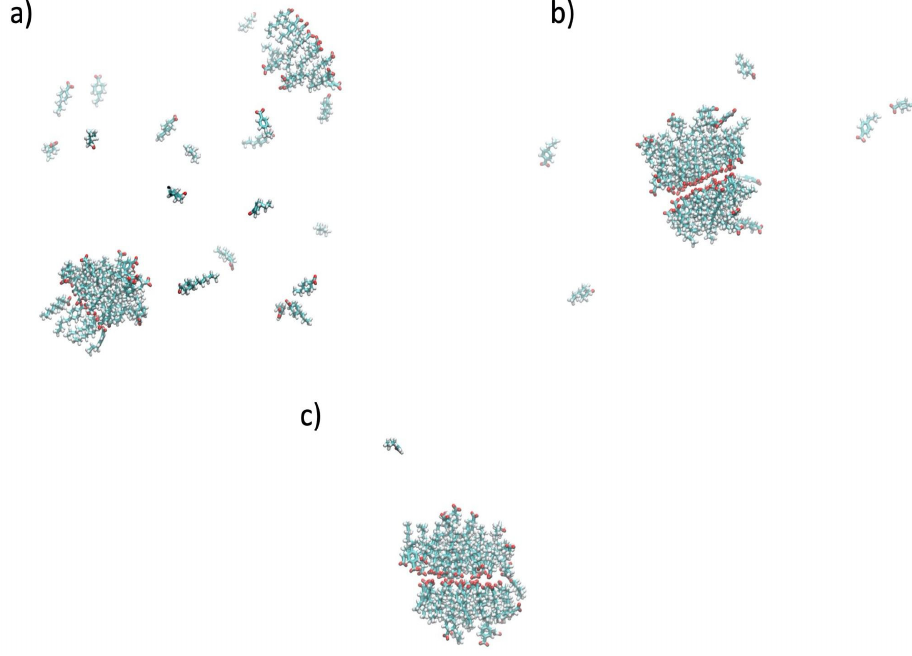
Figure 6. Structure of the NA mixture corresponding to the last frame of the MD trajectory: ( a ) pure water, ( b ) low salinity solution (NaCl 35 g/L), and ( c ) high salinity solution (NaCl 90 g/L).